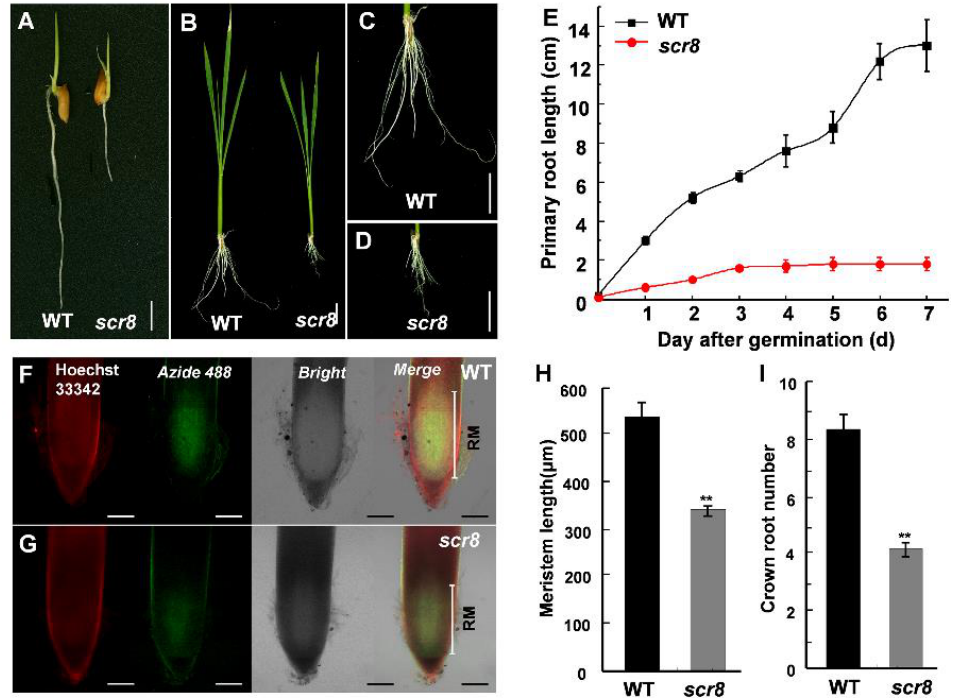
Figure 2. The meristem activity of WT and scr8 . ( A ) Root phenotype of 3-day-old WT and scr8 . Scale bars, 1 cm. ( B – D ) Root phenotype of 30-day-old WT and scr8 . Scale bars, 1 cm. ( E ) Primary root length of WT and scr8 after germination (n = 10). ( F ) and ( G ) EdU staining analysis of 3-day-old WT and scr8 . Scale bars, 100 µ m. ( H ) Meristem length of 3-day-old WT and scr8 (n = 3). ( I ) Crown root number of 7-day-old WT and scr8 (n = 10). Error bars represent SD. ** Significant difference at p < 0.01 compared with the WT by Student’s t -test.